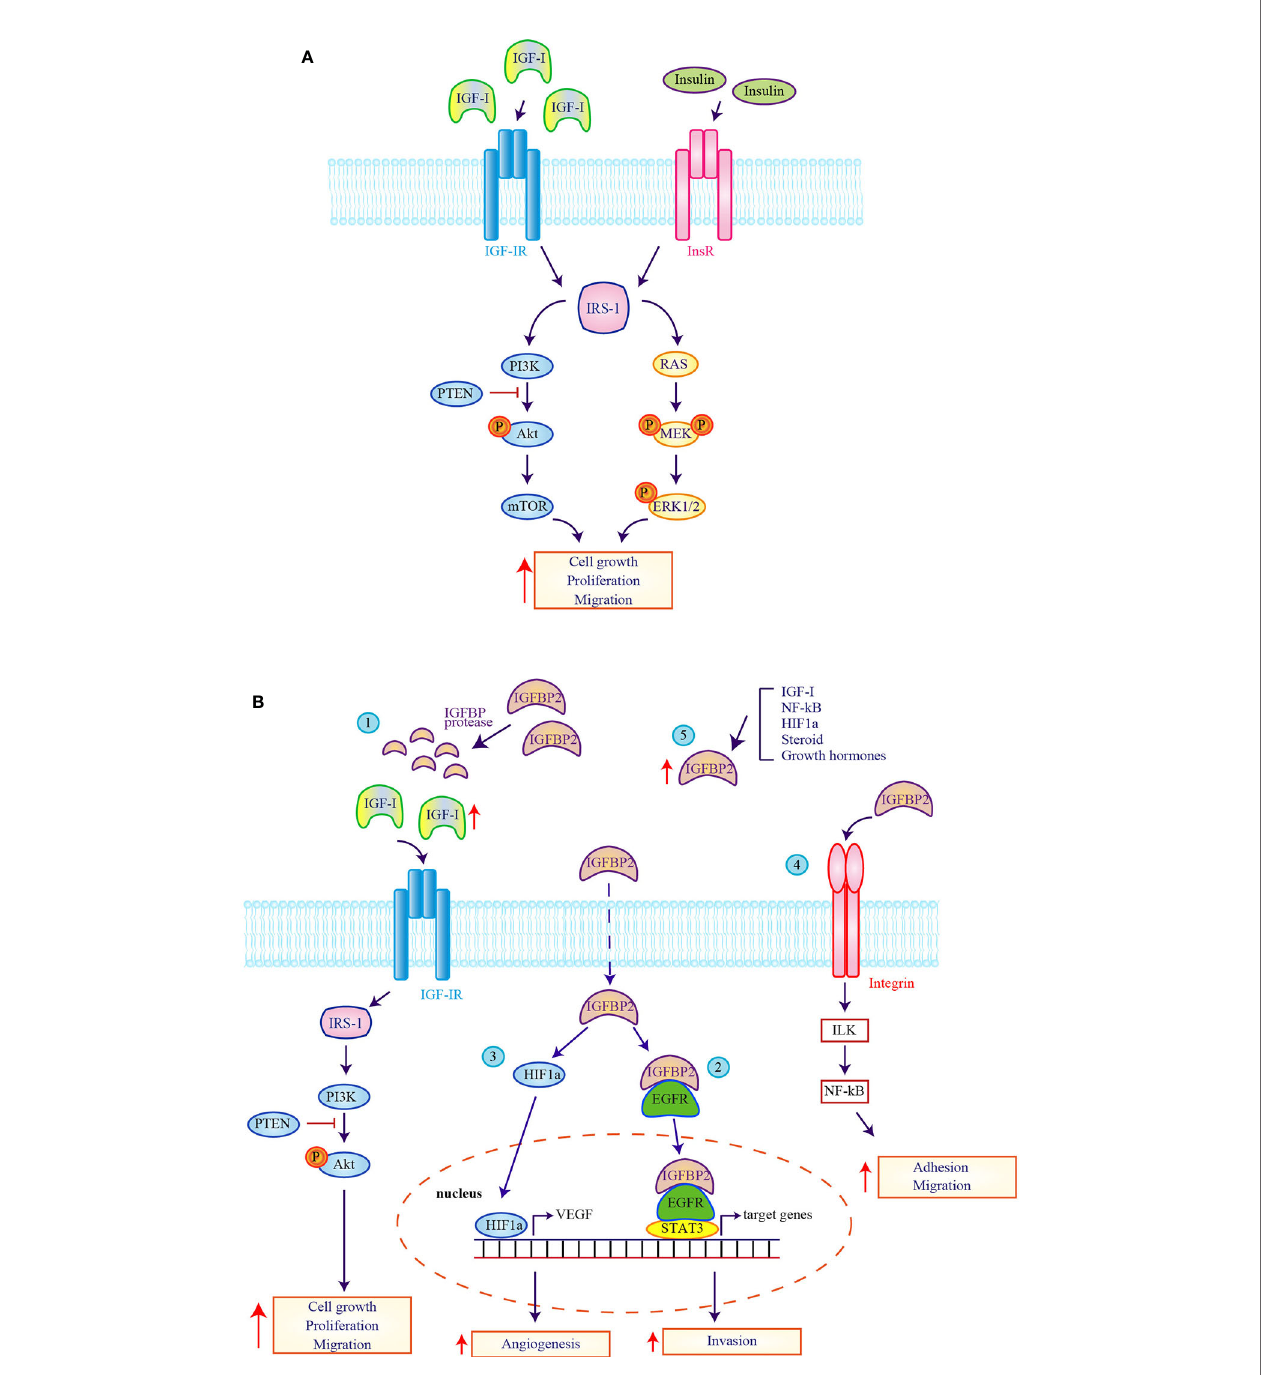
FIGURE 1 | Expression and function of the insulin/insulin-like growth factor system in glioblastoma cells. (A) The pathogenesis and progression of glioblastoma multiforme (GBM) is mainly linked to the activation of Insulin-like growth factor 1 receptor (IGF-IR) and insulin receptor (InsR). The stimulation of IGF-IR and the activation of InsR promote the recruitment of IRS-1 and the activation of the mitogenic and pro-survival mediators Akt and ERK1/2 that contribute to increase (upward red arrow) GBM cell growth, cell proliferation and cell migration. (B) A pivotal role in regulating IGF-system action in GBM pathogenesis is provided by IGFBP-2. (1) The improper activity of protease that cleaves IGFBP-2 causes an increase of circulating-free IGFs (upward red arrow) and the subsequent activation of downstream pathway causing an increase on cell growth, cell proliferation and cell migration. The intracytoplasmatic and intranuclear activity of IGFBP-2 determines the activation of EGFR-STAT-3 (2) or HIF1a (3) signaling and the improvement of the transcription of their target genes. IGFBP-2 activates also the integrin signaling (4) which lead to the activation of the IGFBP-2/Integrin/ILK/NF-kB pathway that is responsible of the transcription of genes linked to adhesion and migration. Finally, stimuli induced by IGF-I, NF-kB, HIF1a, steroid and growth hormones (5) increase IGFBP-2 expression (upward red arrow) causing the activation of pathway linked to GBM